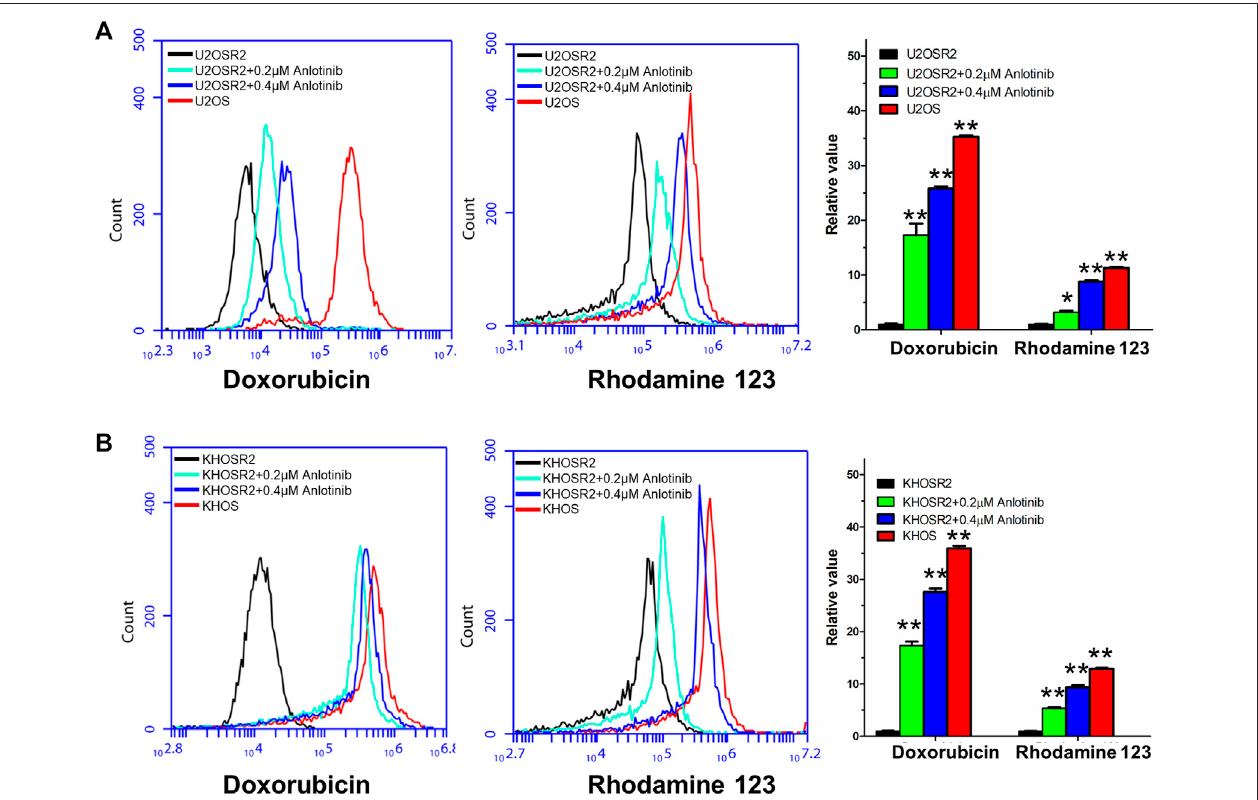
FIGURE 3 | Effect of anlotinib on the intracellular accumulation of DOX and Rho-123 in multidrug-resistant osteosarcoma cells and their respective drug-sensitive parental cells. (A) . The accumulation of DOX and Rho-123 in U2OSR2 and U2OS cells was measured by fl ow cytometric analysis. (B) . The accumulation of DOX and Rho-123 in KHOSR2 and KHOS cells was measured by fl ow cytometric analysis. The results were quanti fi ed as the fold change in fl uorescence intensity between the drug-sensitive parental cells and the paired multidrug-resistant cells. In the presence of anlotinib, the intracellular accumulation of DOX and Rho-123 in the drug- resistantU2OSR2andKHOSR2cellssigni fi cantlyincreasedinadose-dependentmanner.Datarepresentthemean ± SDofatleastthreeindependentexperiments(* p < 0.05; ** p <